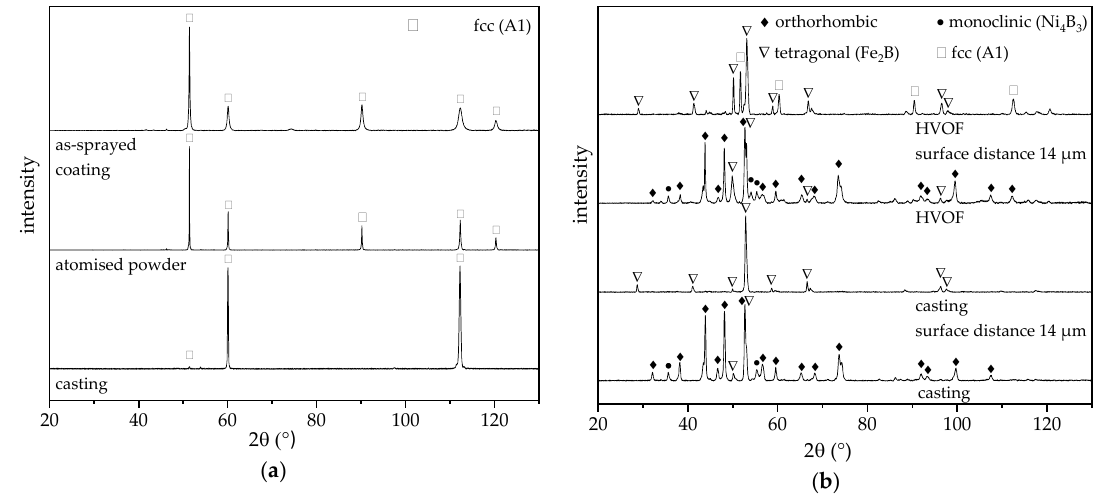
Figure 4. Diffractograms of CrFeCoNi: ( a ) feedstock powder, casting, and HVOF coating in untreated state; ( b ) casting and HVOF coating in borided state.